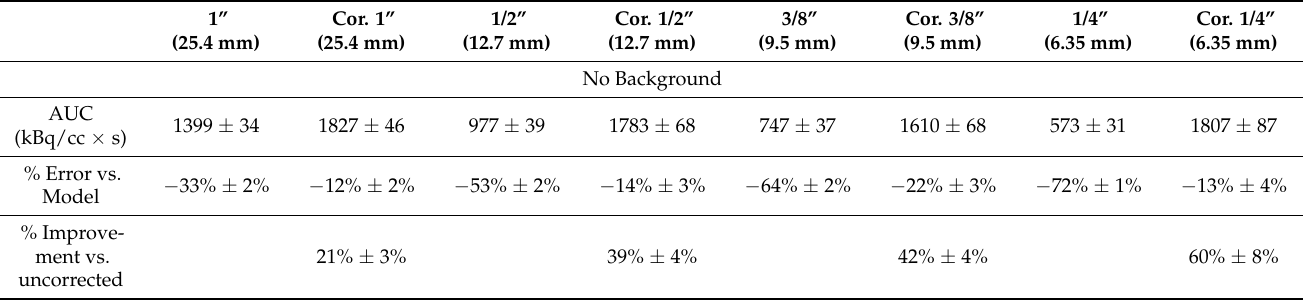
Table 1. Quantitative Results of Input Function PVE correction. (All results are shown ± the standard error of the mean n = 5.)